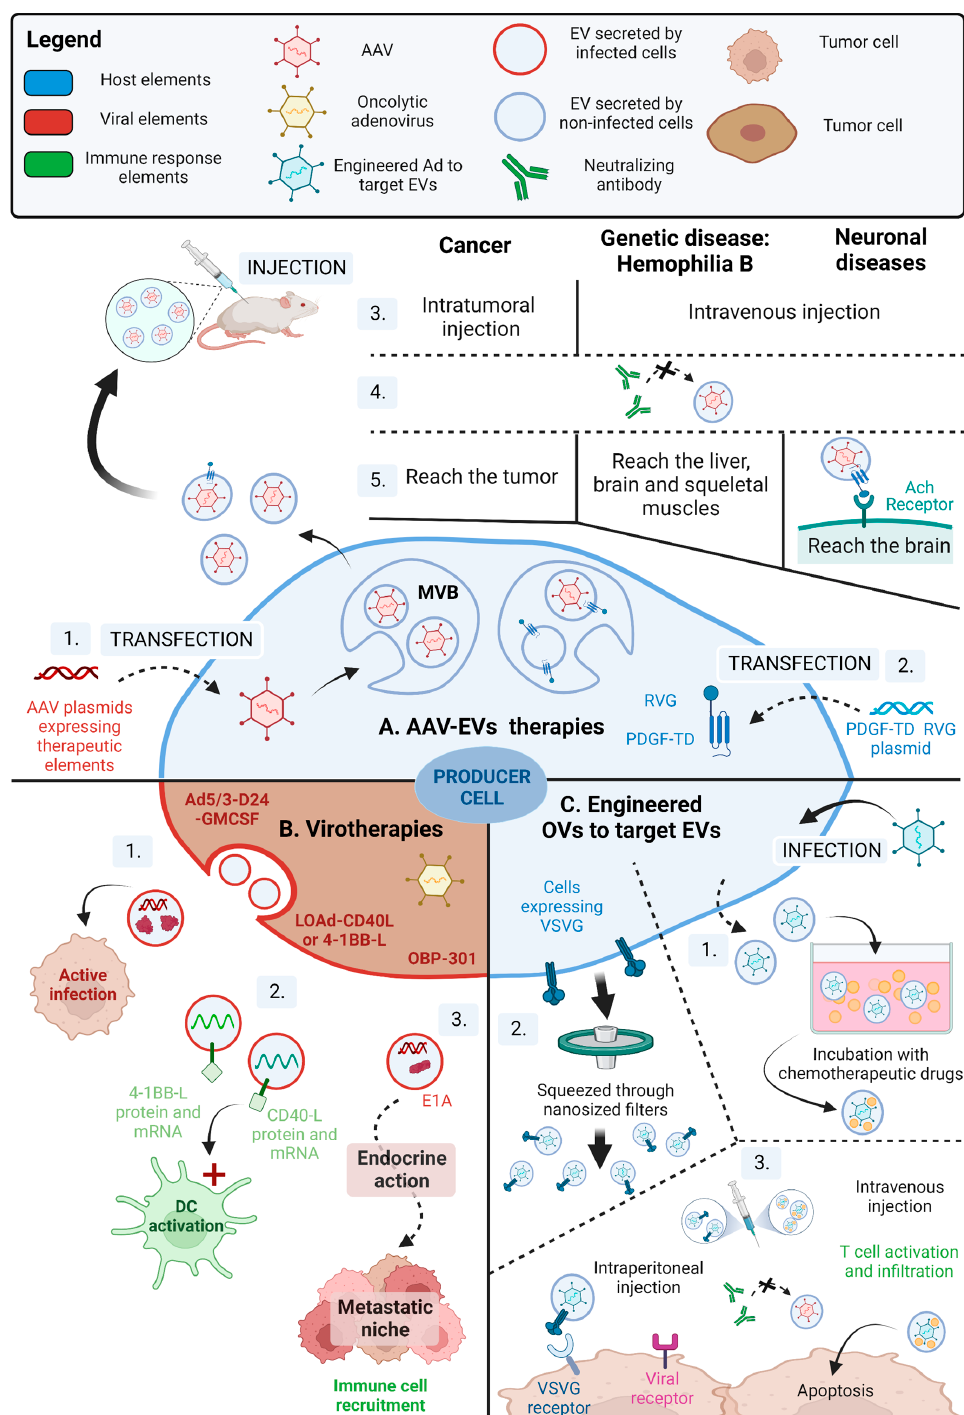
Figure 5. EV-guided improvement of virotherapies. ( A ) AAV-EVs-based therapies. ( A1 ) Producer cells (HEK293 or 293T cells) are transfected with AAV plasmids expressing different therapeutic elements to be delivered to the appropriate tissue. ( A2 ) In addition, producer cells can be co-transfected with other plasmids. For instance, PDGF-transmembrane domain fusioned to RVG allows targeting of RVG to EVs thanks to PDGT-TD. Then, RVG mediates EVs binding to the acetylcholine (Ach) receptor of